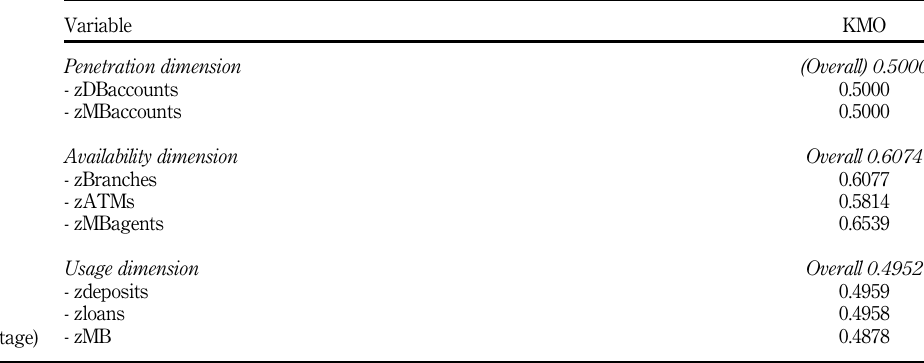
Table A2. Scoring coefficients for orthogonal varimax rotation (weights)